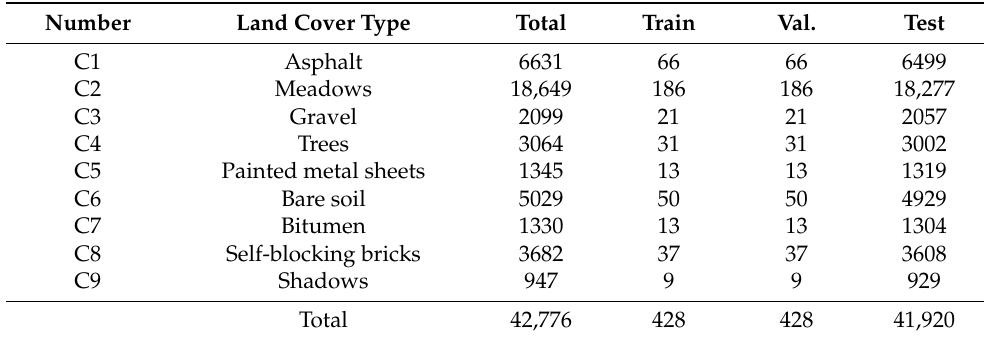
Table 6. The number of total samples, training samples, validation samples, and testing samples for each category of the PU dataset.